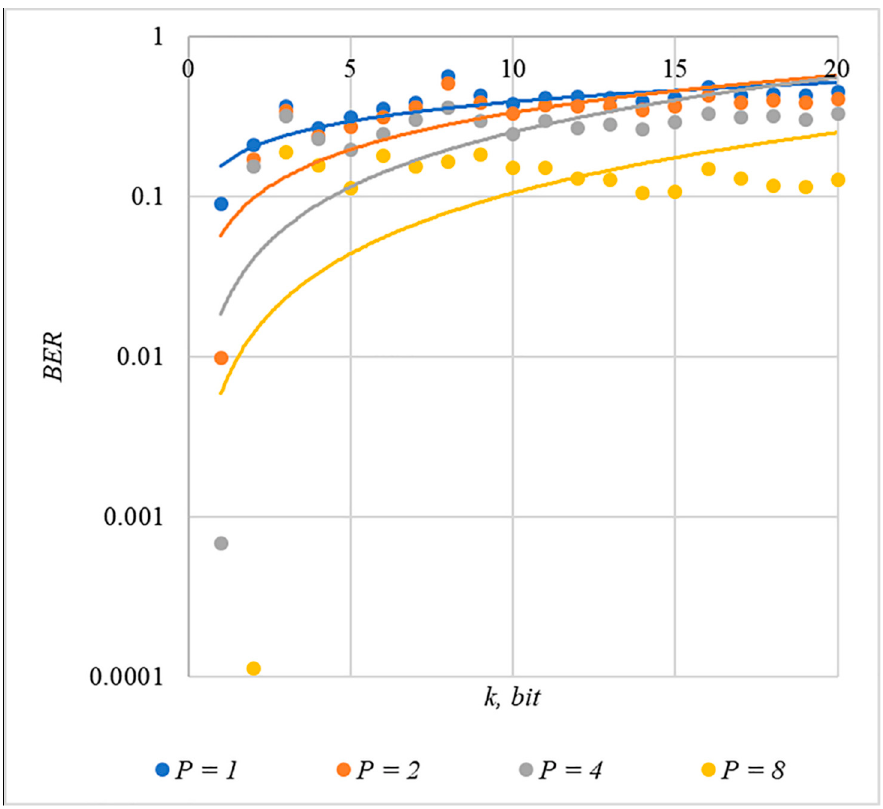
P rule for generating chip codes № 1.